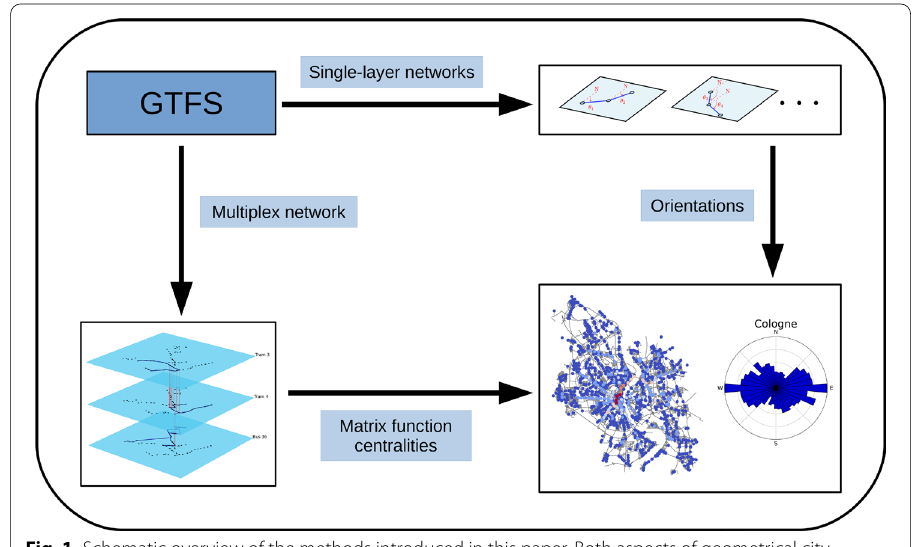
Fig. 1 Schematic overview of the methods introduced in this paper. Both aspects of geometrical city modeling rely on GTFS timetable data, which is described in the "Data" section. The methodology for the computation of public transport orientations using sequences of single-layer networks is described in the "Methodology" section. Details on the construction of the multiplex network representation of urban public transport systems are given in the "Multiplex network model" section. The methodology for the determination of the centrality of stops and lines of the multiplex networks using matrix function-based centrality measures is presented in the sections “Definition” and “Numerical